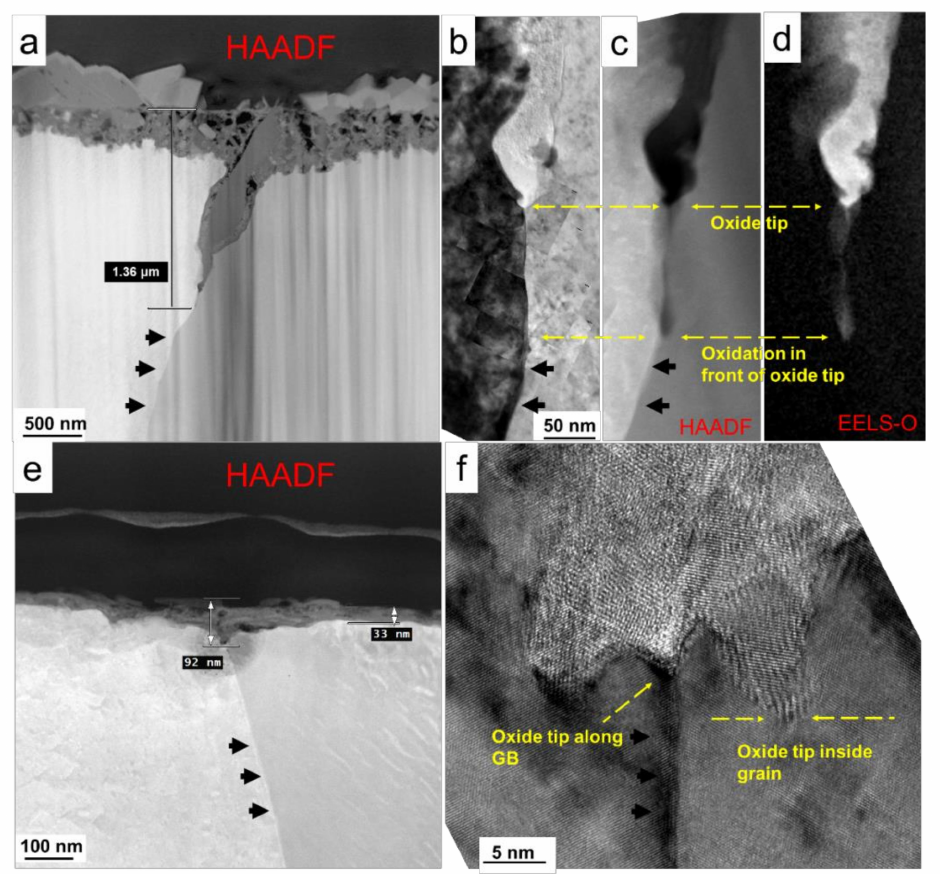
Figure 4. ( a ) HAADF image at the GB of the Ar-exposed specimen; and the related ( b – d ) magnified TEM-BF, HAADF, and O intensity images of the oxide tip of the GB; ( e ) HAADF image at GB for the H-exposed specimen, and the related ( f ) magnified TEM-BF image of the oxide tip of the GB